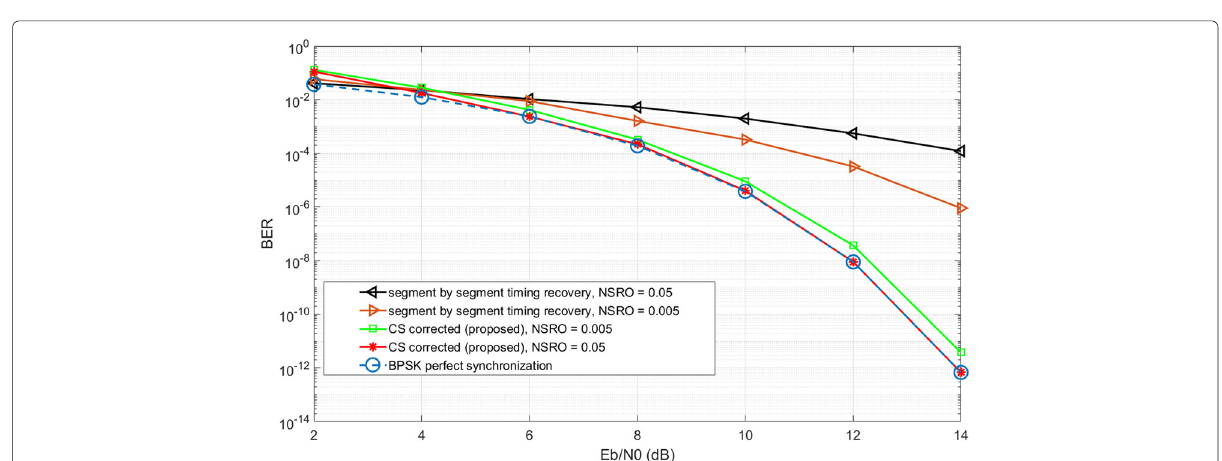
Fig. 8 BER performance of typical approach and introduced algorithm for η = 0.05 and η = 0.005, N (cid:2) = 4096, N = 300, modulation type = BPSK